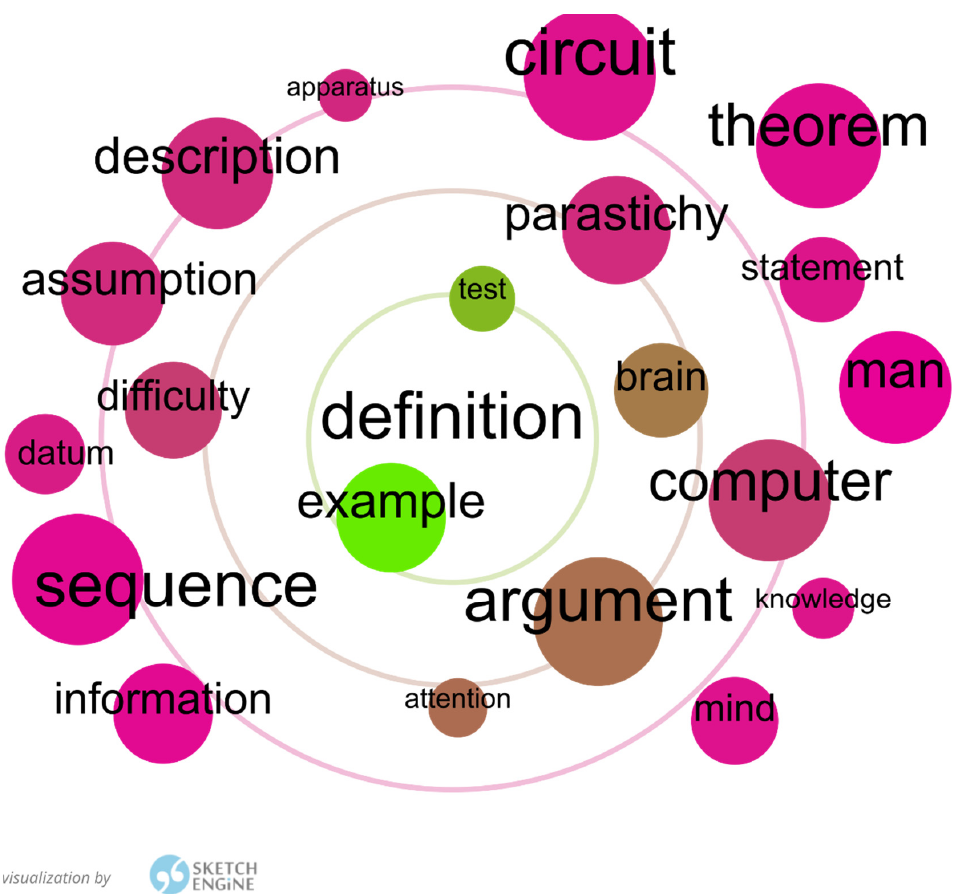
Figure 8. Terms that are semantically close to “definition” in Turing’s corpus.